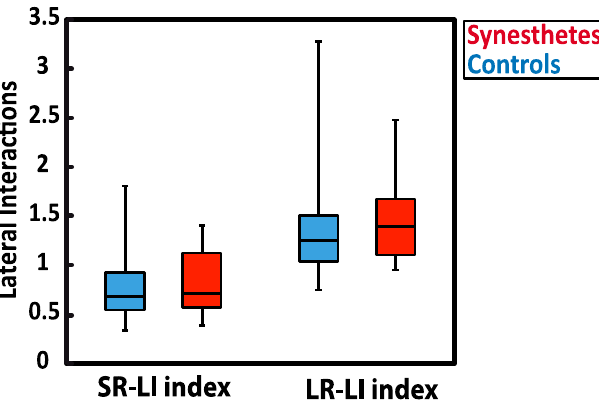
Figure 3. Lateral interaction indices for synesthetes (red) and controls (blue). The SR-LI index measures the relationship between F1 and F2 magnitudes of the W/D response and reflects the activity of short-range lateral interactions. The LR- LI index measures the magnitude change in F2 of the P-W/D in reference to the F2 magnitude of the W/D and reflects long-range lateral interaction activity. The whiskers indicate the minimum and maximum range of the distributions, the top and bottom of the boxes show the first and third quartiles (25th and 75th percentile), and horizontal bars inside the boxes represent the medians.